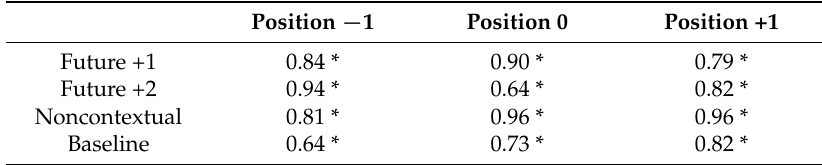
Table 1. Correlations of mean N1 and P2 amplitudes at target event positions − 1, 0, and +1 for each feedback condition. * df = 22, p < 0.001.